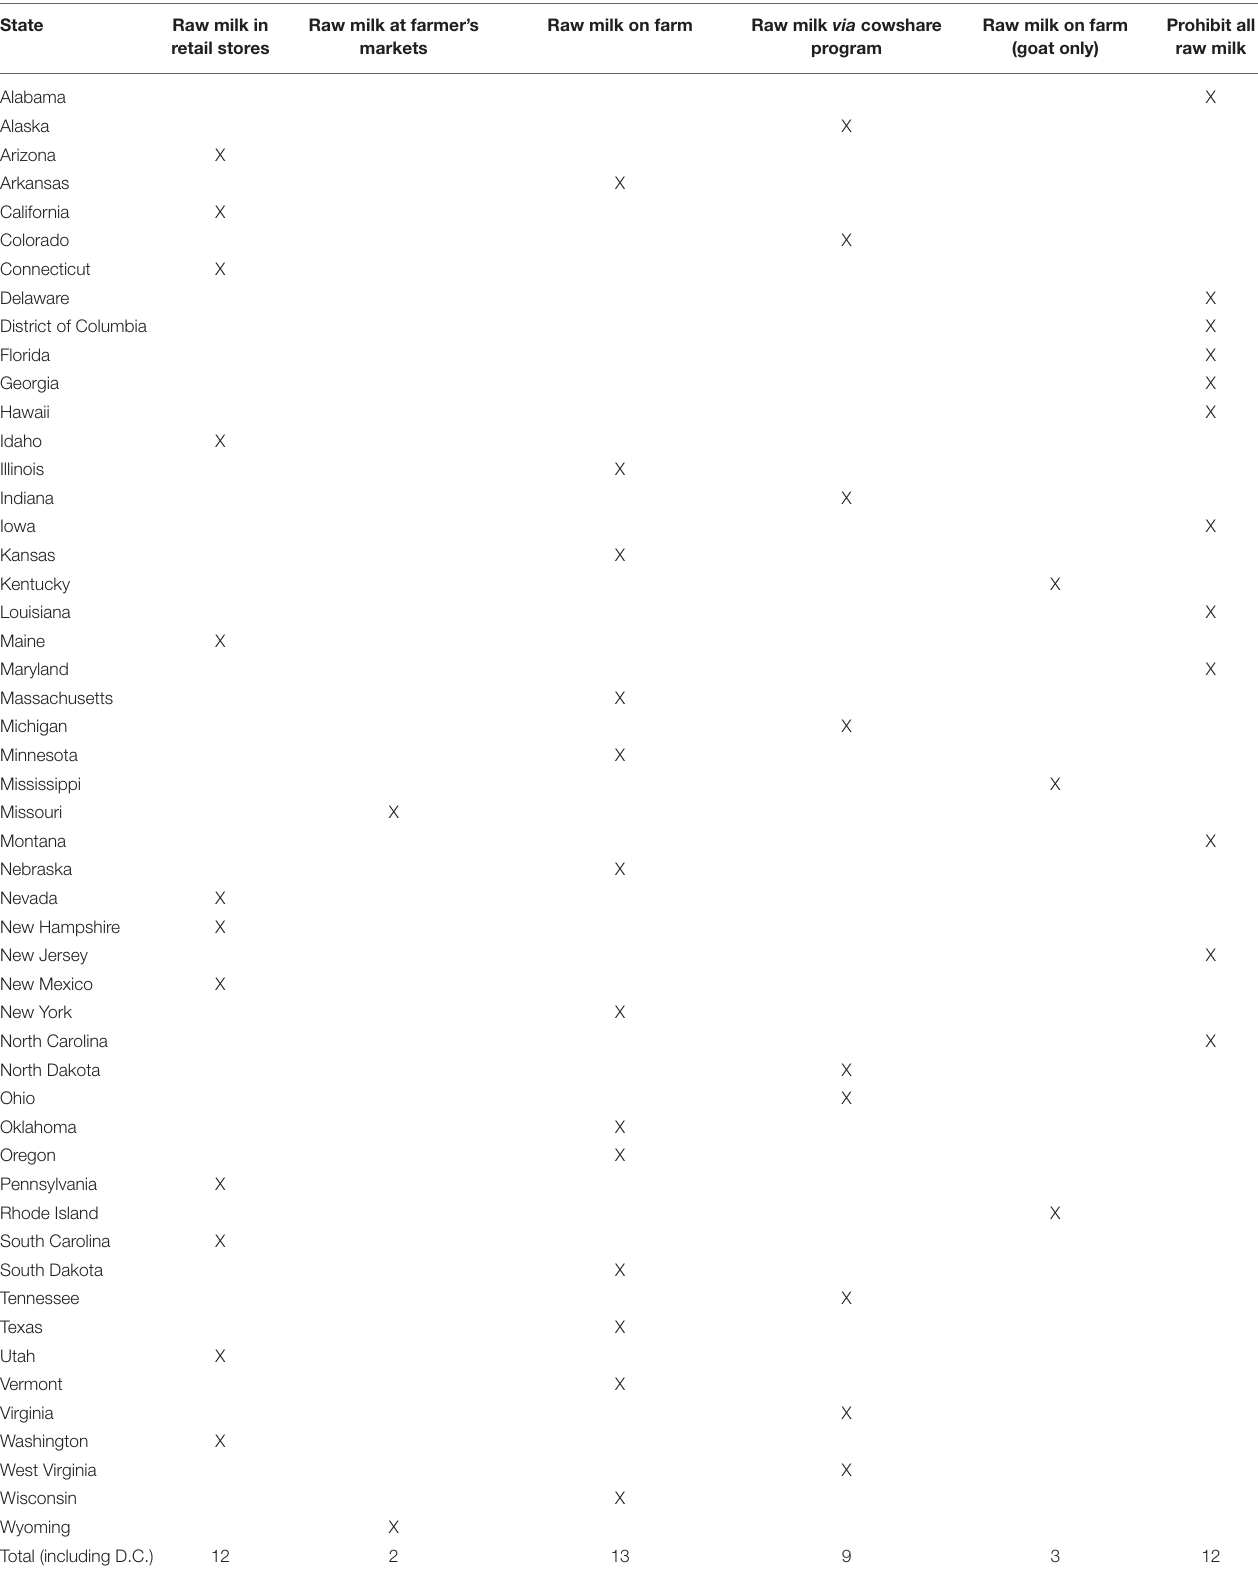
TABLE 1 | Raw milk access across the United States. State Raw milk in